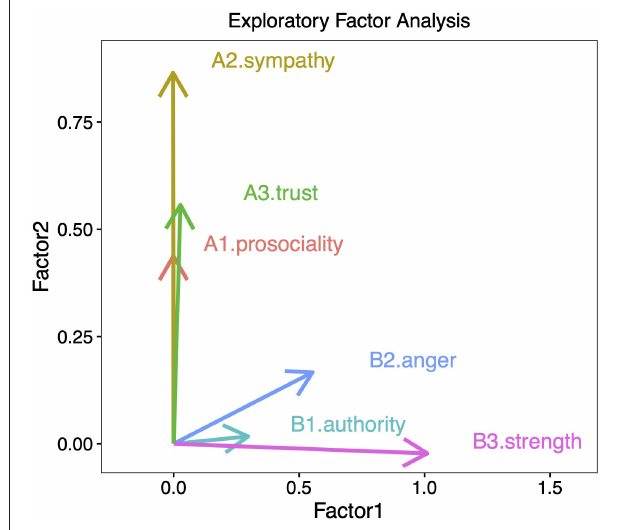
FIGURE 2 | Factor analysis including six variables. Three variables are potentially related to cooperation (prosociality, sympathy, and trustworthiness) and three variables are potentially related to dominance (authority, anger, and strength). The analysis shows that cooperation-related variables load higher on Factor 2, while variables related to dominance load higher in Factor 1 ( Martins and Baumard, 2020).